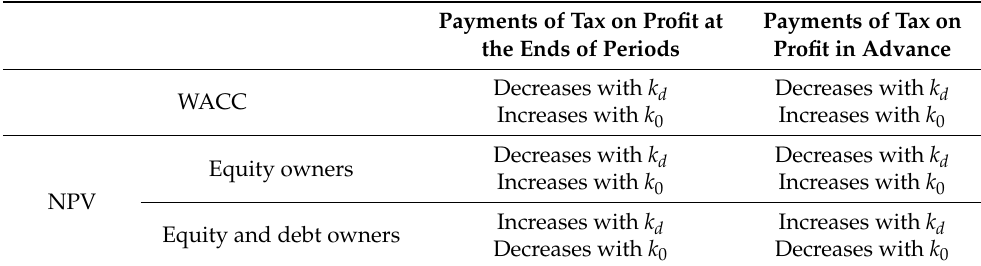
Payments of Tax on Profit in Advance Decreases with k d Increases with k 0 Decreases with k d Increases with k 0 Increases with k d Decreases with k